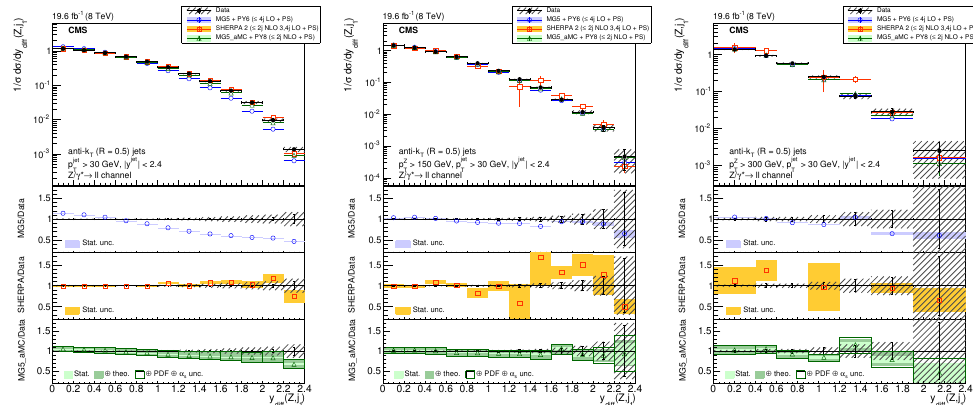
Figure 10 . The normalised di(cid:11)erential cross section for Z ( ! ‘‘ ) + jets ( N jets (cid:21) 1) production measured as a function of the y di(cid:11) of the Z boson and the leading jet compared to the predictions calculated with MadGraph 5 + pythia 6, sherpa 2, and mg5 a mc + pythia 8. (left) The cross section is measured inclusively with respect to the Z boson p T and for two di(cid:11)erent p T (Z) thresholds. The ratio of the prediction to the measurements is shown for (left) p T > 0 GeV, (middle) p T > 150 GeV, and (right) p T > 300 GeV. The lower panels show the ratios of the theoretical predictions to the measurements. Error bars around the experimental points show the statistical uncertainty, while the cross-hatched bands indicate the statistical and systematic uncertainties added in quadrature. The boxes around the mg5 a mc + pythia 8 to measurement ratio represent the uncertainty on the prediction, including statistical, theoretical (from scale variations), and PDF uncertainties. The dark green area represents the statistical and theoretical uncertainties only, while the light green area represents the statistical uncertainty alone.